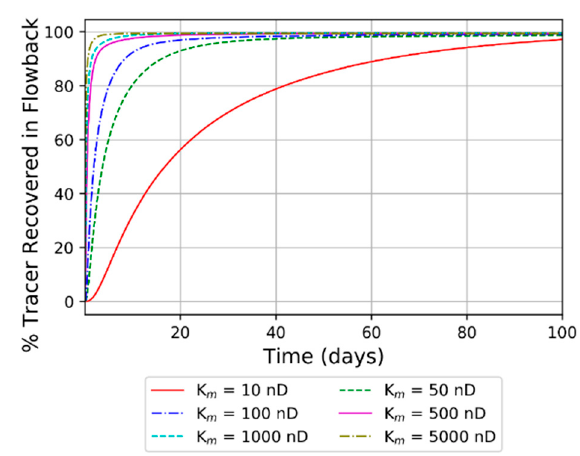
Figure 9. Flowback tracer recovery vs. time when fracture closure is not modeled.